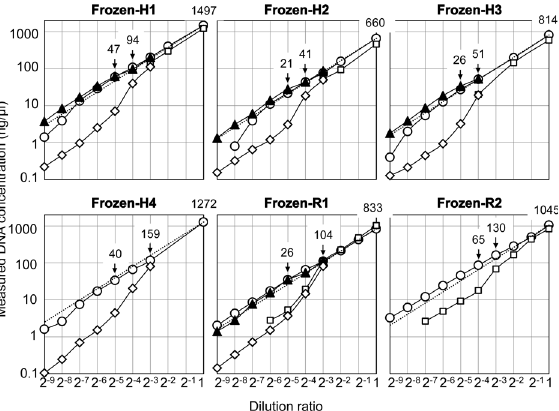
Fig 1. Dilution curves of Frozen-DNA diluted with distilled water as determined by NanoDrop, Qubit and qPCR. Each Frozen-DNA sample was serially diluted with distilled water, and the concentration of each diluent was measured by NanoDrop (circles), BR-Qubit (squares), HS-Qubit (diamonds) and qPCR (triangles). The broken line shows the expected NanoDrop value. The concentration (ng/ μ l) of each original DNA solution measured by NanoDrop is shown at the top right: dilution ratio = 1. Two additional concentrations are also shown in each graph. The detection limits of NanoDrop, BR-Qubit, HS-Qubit and qPCR are 2 ng/ μ l, 2 ng/ μ l, 0.2 ng/ μ l and 1 pg/ μ l, respectively.